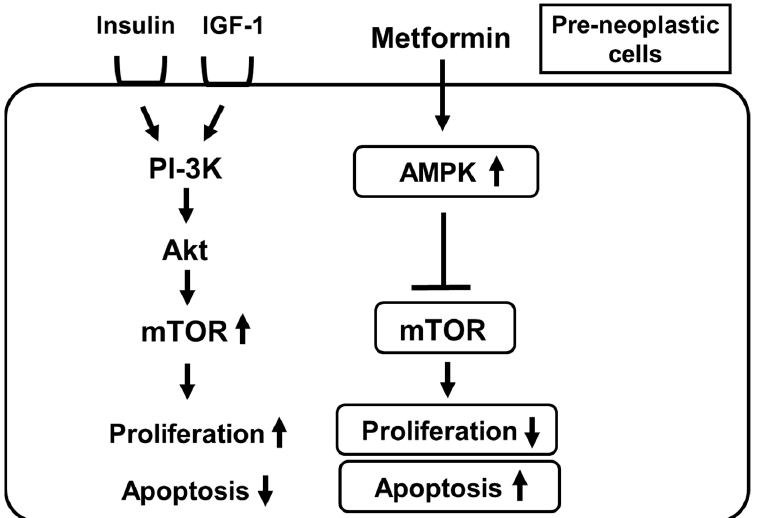
Figure 3. Metformin suppresses the mechanistic target of rapamycin (mTOR) by activating AMPK in pre-neoplastic cells which leads to suppression of cell growth and an increase in apoptosis in pre-neoplastic cells. IGF-1, insulin-like growth factor; PI-3K, phosphatidylinositol-3 kinase; Akt, protein kinase B.